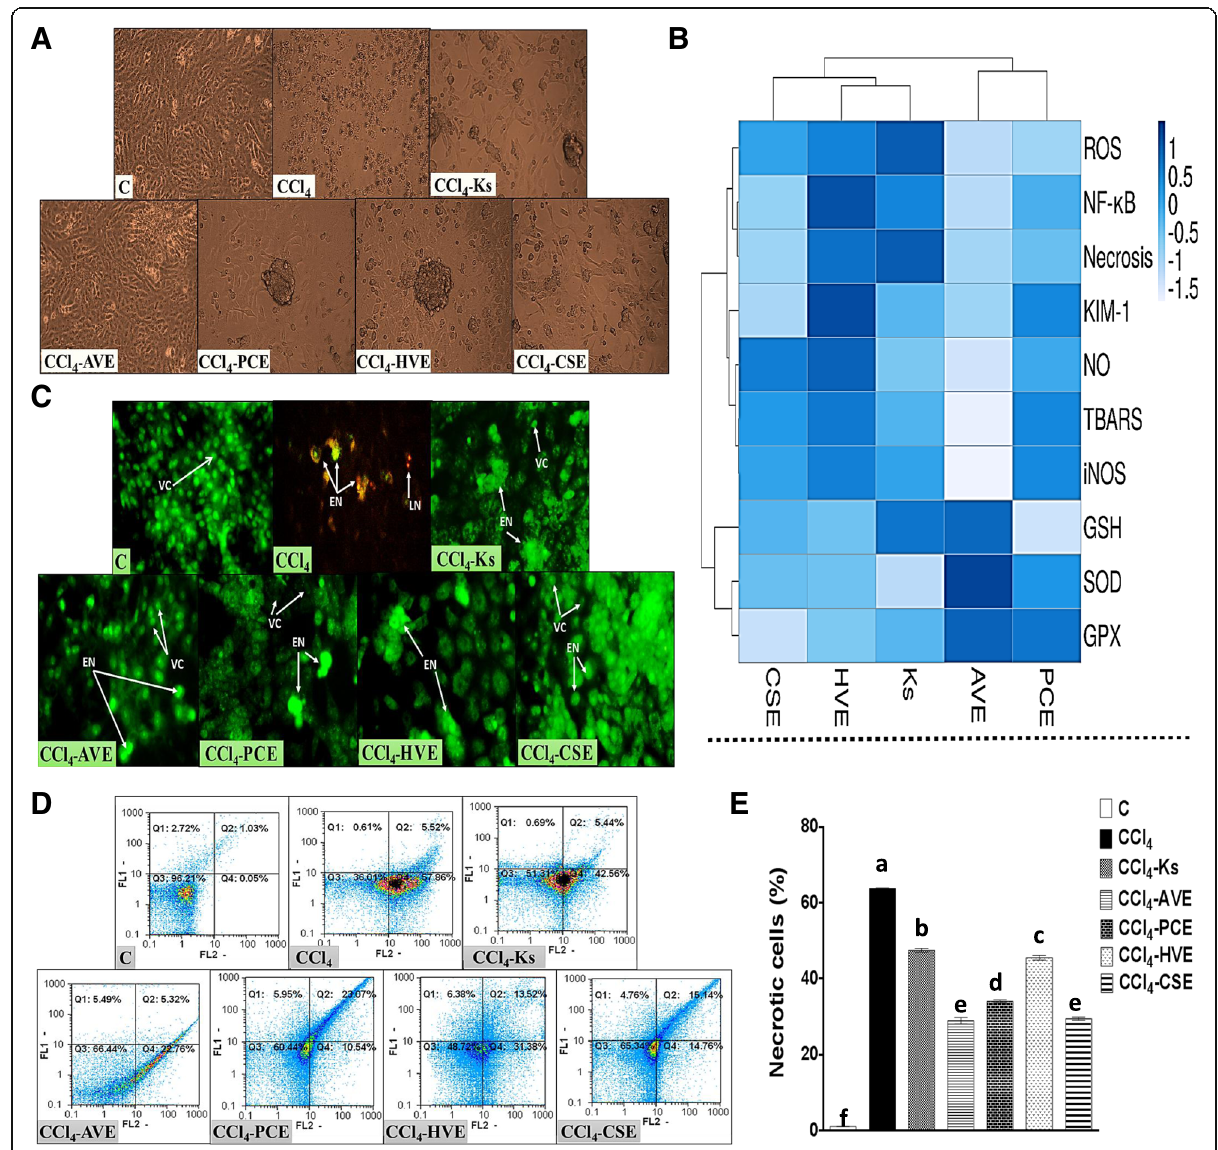
Fig. 5 Microscopic investigation and flow cytometric analysis for the carbon tetrachloride (CCl 4 )-induced necrosis in Vero Cells and the anti- necrotic effect of the studied extracts in comparison with the Ketosteril (Ks). ( a ) Photomicrographs taken by the inverted microscope ( b ) Heat map distribution of the necrotic mediators, the color distributed from white (low level/expression or activity) to blue (high level/expression or activity) ( c ) Nuclear double staining of Vero cells using acridine orange (AO)/ethidium bromide (EB) ( d ) Annexin V/Propidium Iodide (PI) flow cytometry charts ( e ) Quantification of the necrotic cell populations, results are presented as mean ± SE ( n = 3). Different letters for the same parameter are significantly different at p < 0.05. C ; the untreated control cells, AVE , Ammi visnaga extract; PCE , Petroselinum crispum extract; HVE , Hordeum vulgare extract; CSE , Cymbopogon schoenanthus extract; VC , viable cells; EN , Early necrotic cells; LN , Late necrotic